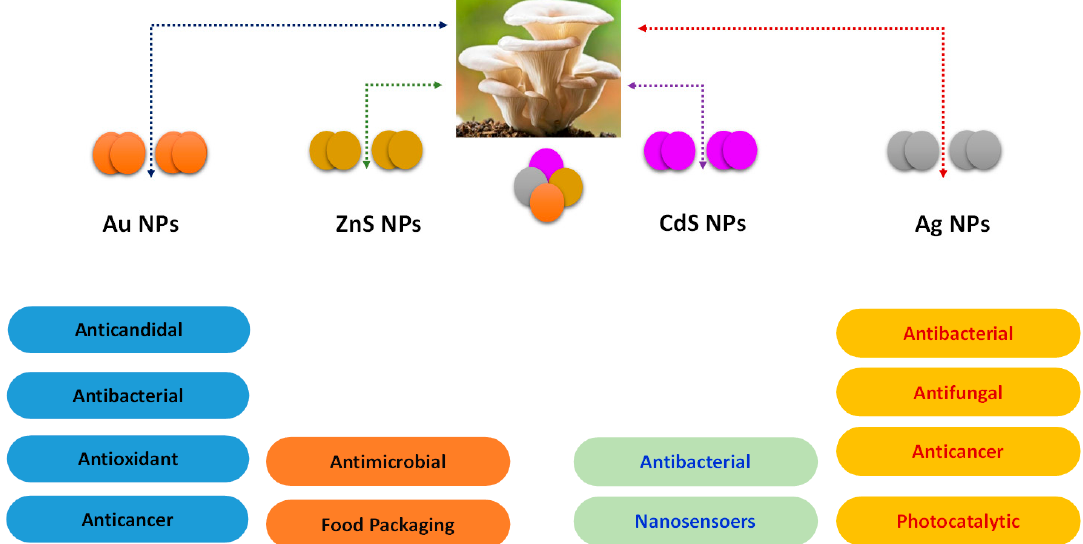
Figure 2. Schematic diagram showing the applications of Oyster mushroom derived nanoparticles.